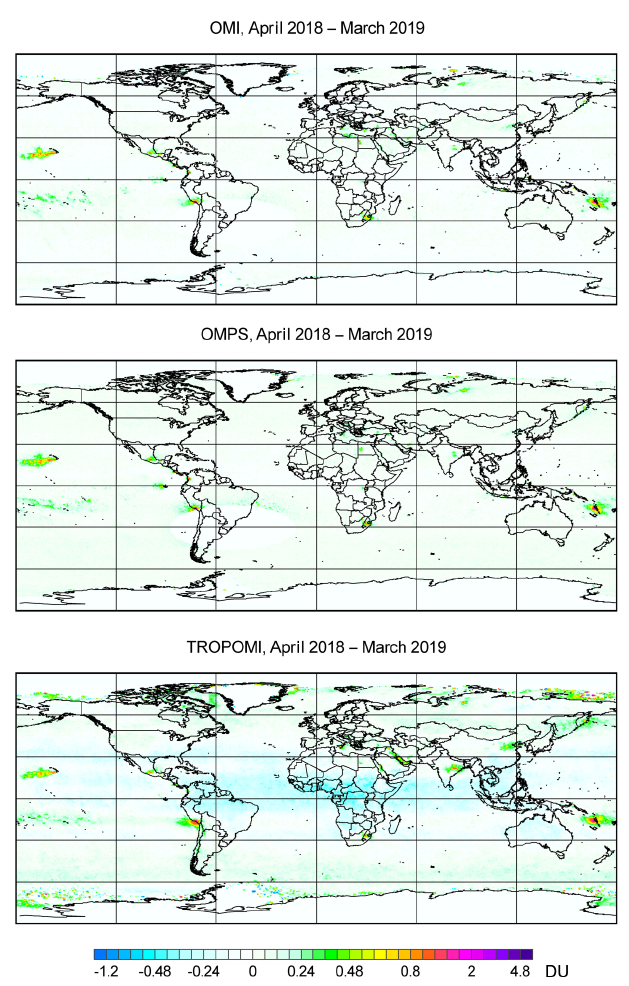
Figure 3. Mean SO 2 (DU) over the globe from TROPOMI, OMI, and OMPS for the period from April 2018 to March 2019. Data are smoothed by oversampling techniques with radius R = 30km. The area of the South Atlantic Anomaly (SAA) is left blank on the OMI and OMPS maps. The SAA greatly increases uncertainties of OMI and OMPS SO 2 data but has a much smaller effect on TROPOMI SO 2